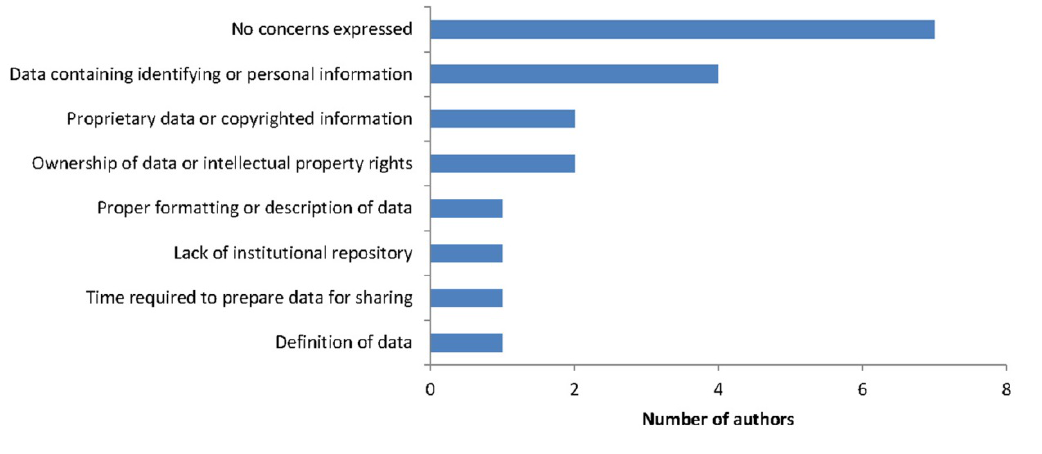
Of the 15 authors who responded to our email, 7 expressed no concerns, whereas 8 expressed 1 or more concern about data